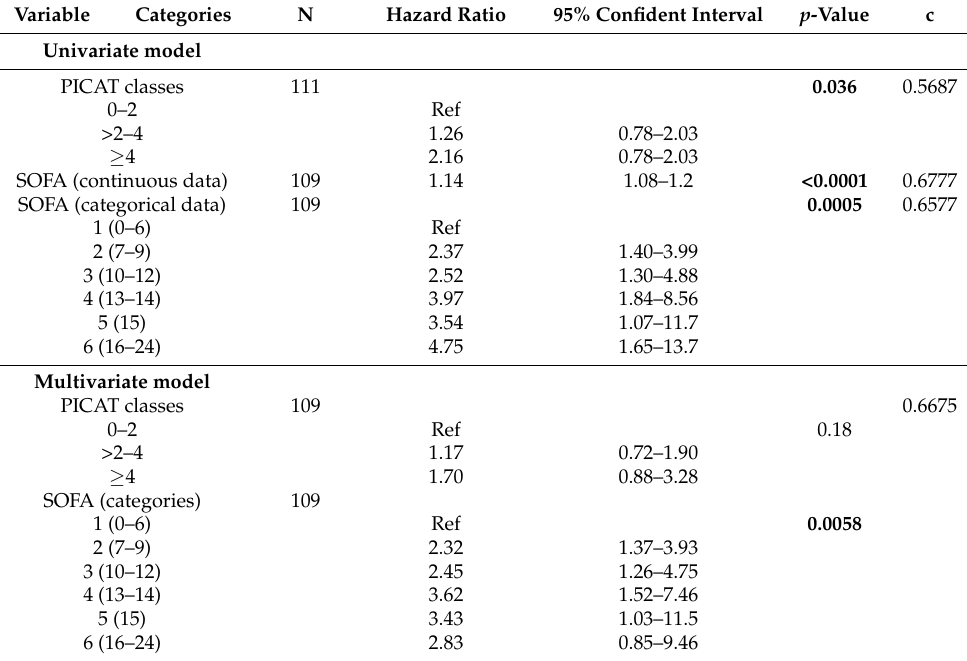
Table 5. Cox-regression and c-statistics analysis of